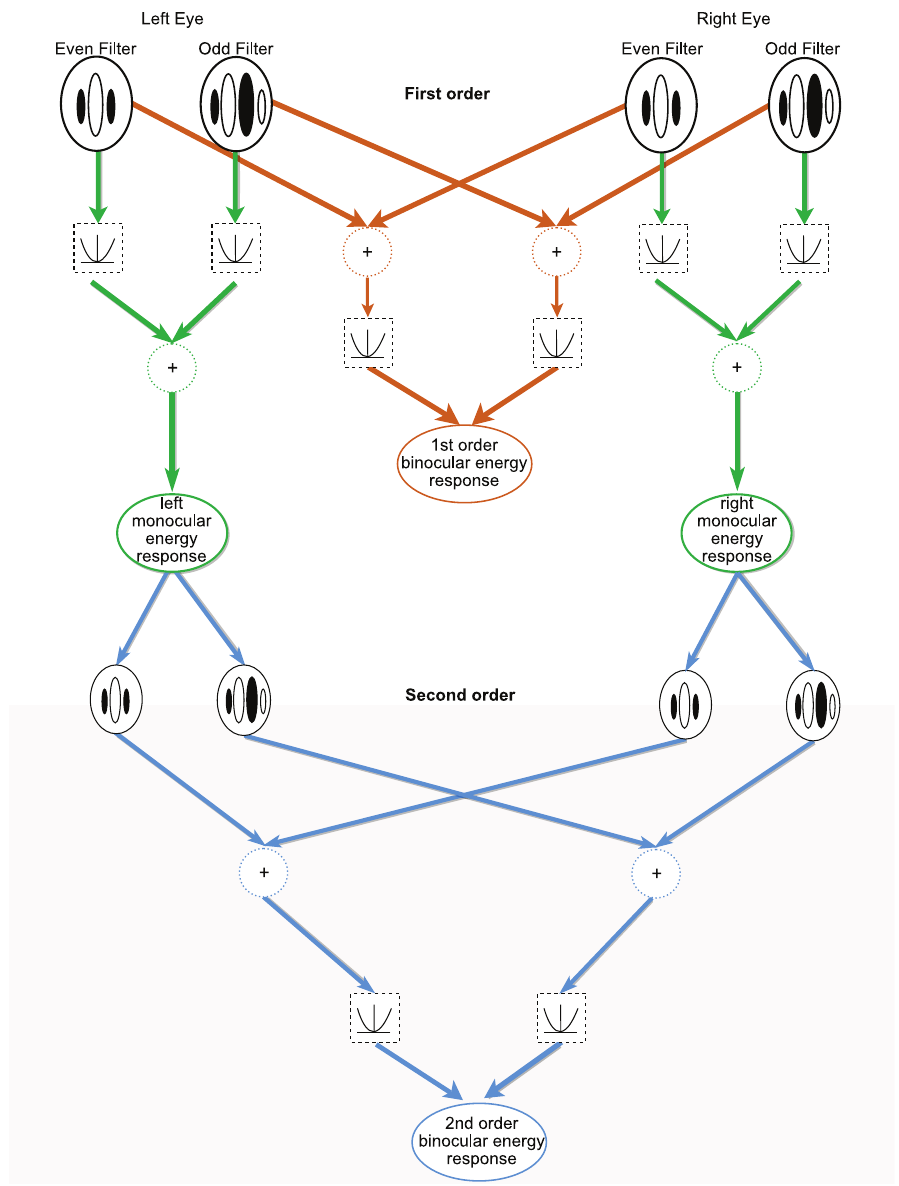
Fig 2. Outline of a first order binocular energy model (orange pathway): Odd and even symmetric monocular receptive fields (white areas represent excitatory regions of the receptive fields and dark areas inhibitory regions) are combined to compute the first order binocular energy response. Responses are summed across the two eyes for corresponding filters, then squared. The squared outputs are summed across the two halves of the quadrature pair. Outline of a second order binocular energy model (green and blue pathway): Odd and even monocular energy responses are calculated separately for each eye (green pathway). The first-order responses are squared and summed, to produce monocular energy responses for each eye. This forms the input to the second order filters (blue pathway) where the pairs of monocular filters are summed, squared and combined to calculate the second-order binocular energy